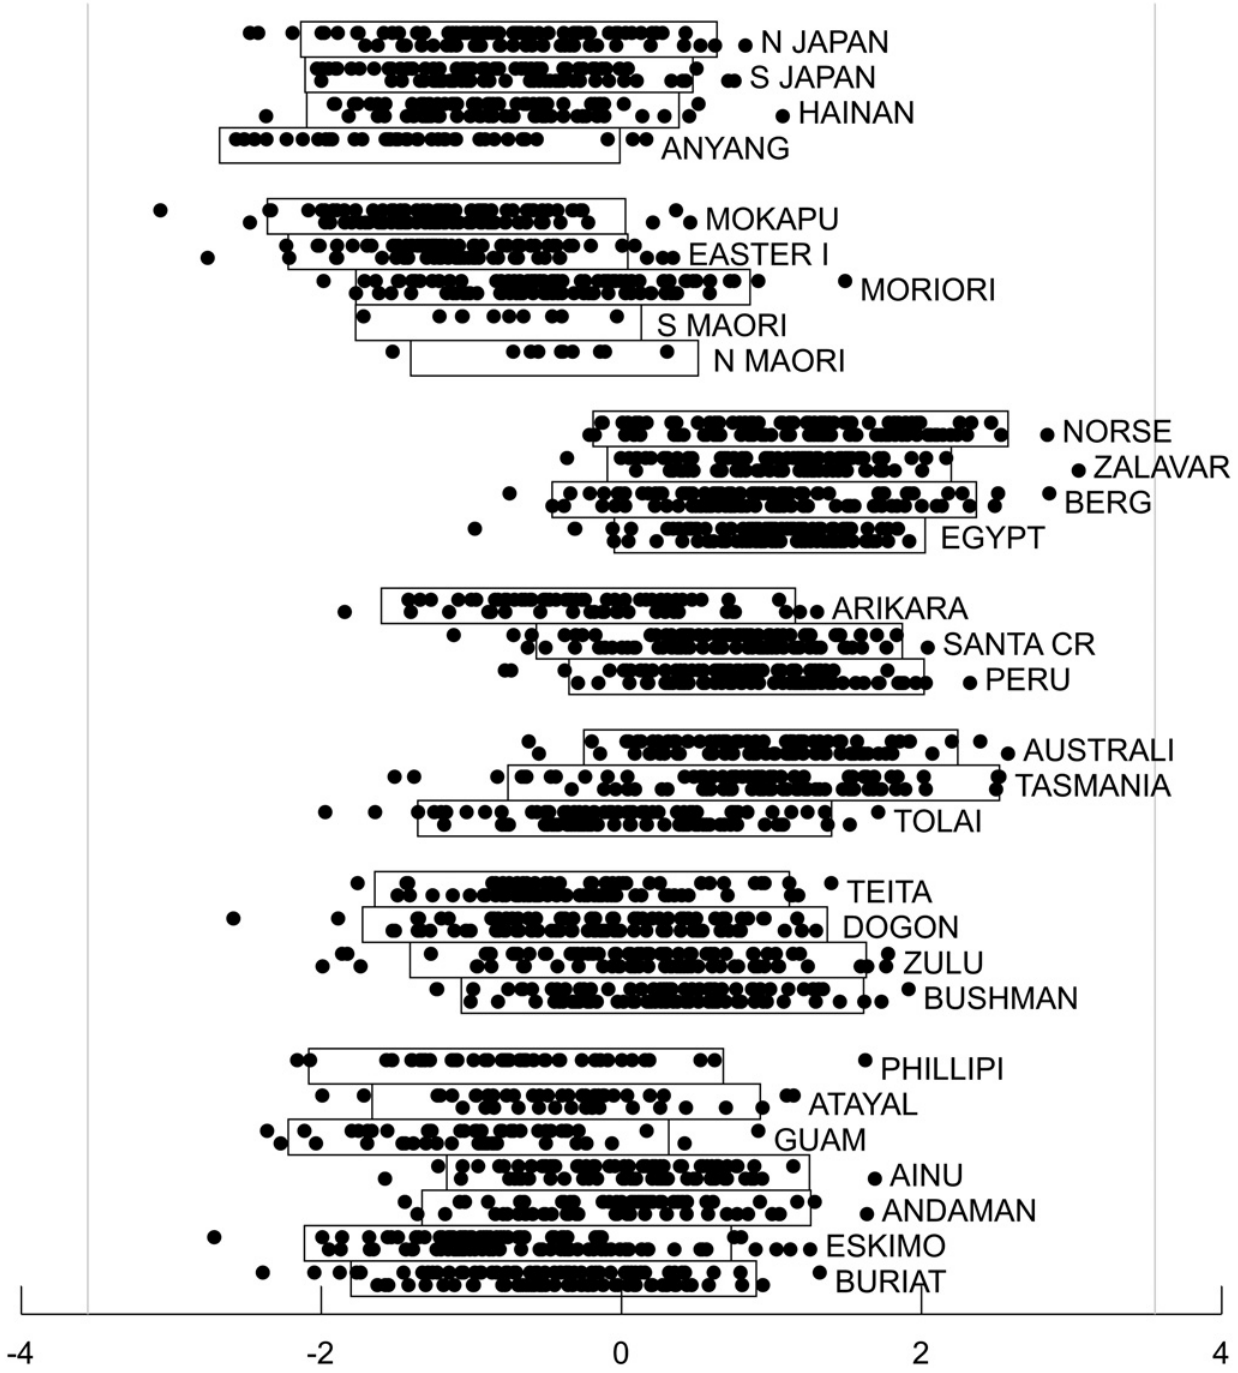
Fig 9. Sub-Gaussian source separating the Far Eastern group and the European group from one another. Source scores are derived from the best fitting model. This source accounts for 10.0% of the variance of the original data set. See Fig. 6 legend for additional details.